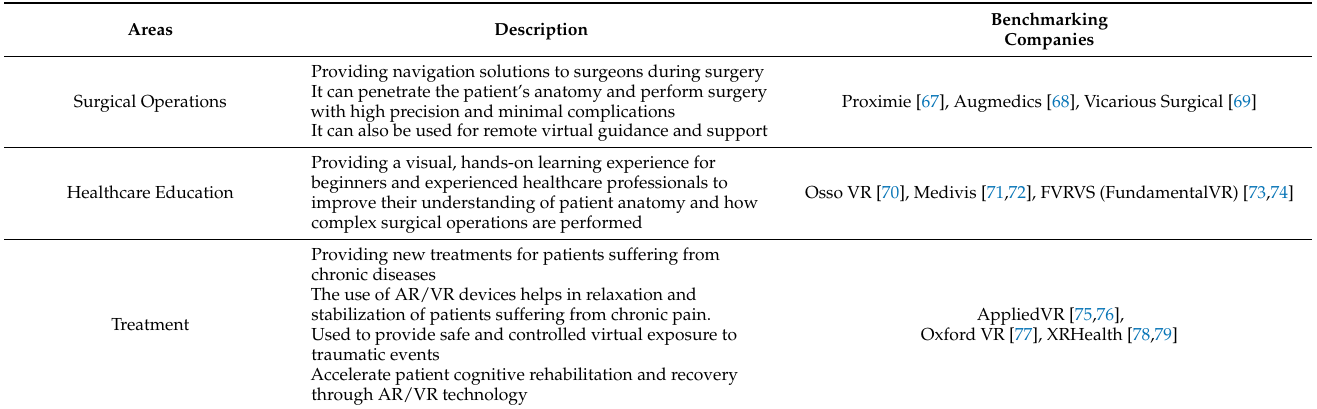
Table 3. Metaverse Application in Healthcare Industry.